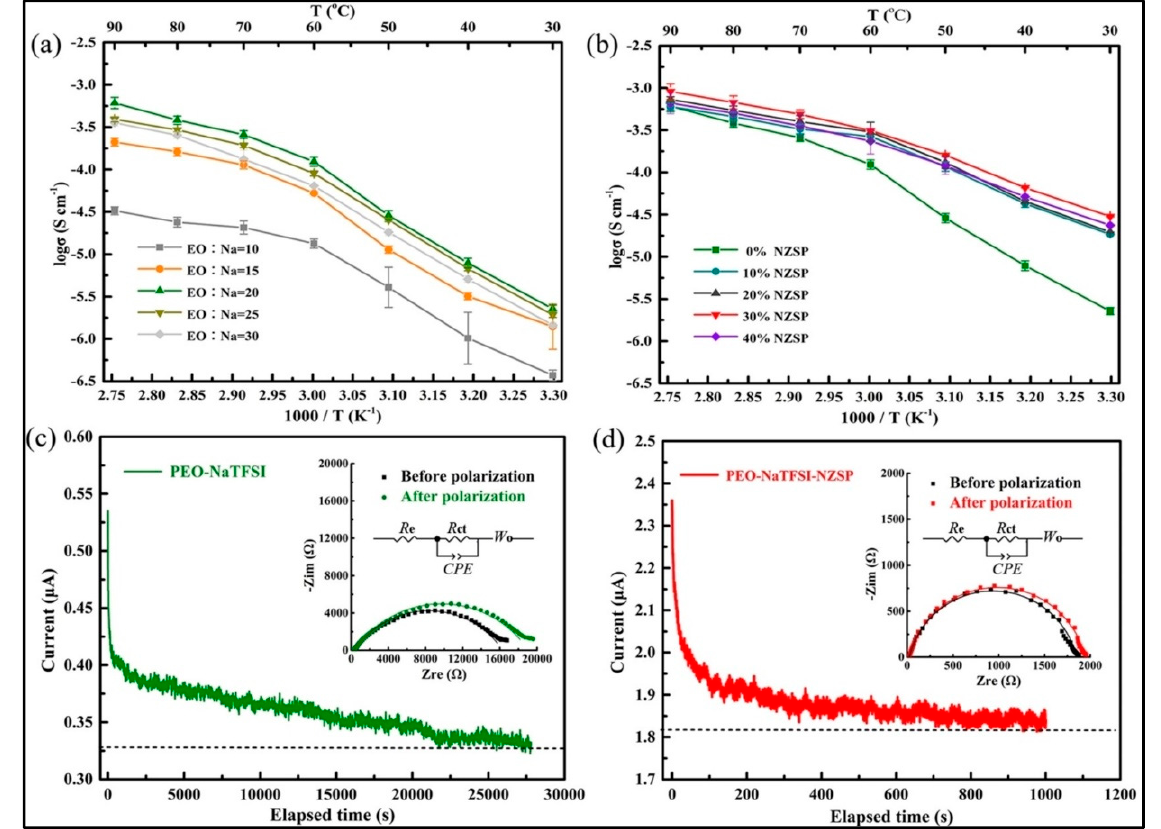
Figure 11. ( a ) Ionic conductivity of PEO–NaTFSI-based electrolyte at different EO:Na + ratios; ( b ) ionic conductivity of PEO–NaTFSI/Na 3 Zr 2 Si 2 PO 12 at various weight ratios of Na 3 Zr 2 Si 2 PO 12 ; ( c ) Ac impedance and chronoamperometry of Na|| PEO–NaTFSI ||Na cell; ( d ) equivalent circuit used to fit the impedance data. (Reprinted with permission from [144]; Copyright 2022, ChemistrySelect 2022 , 7 .)